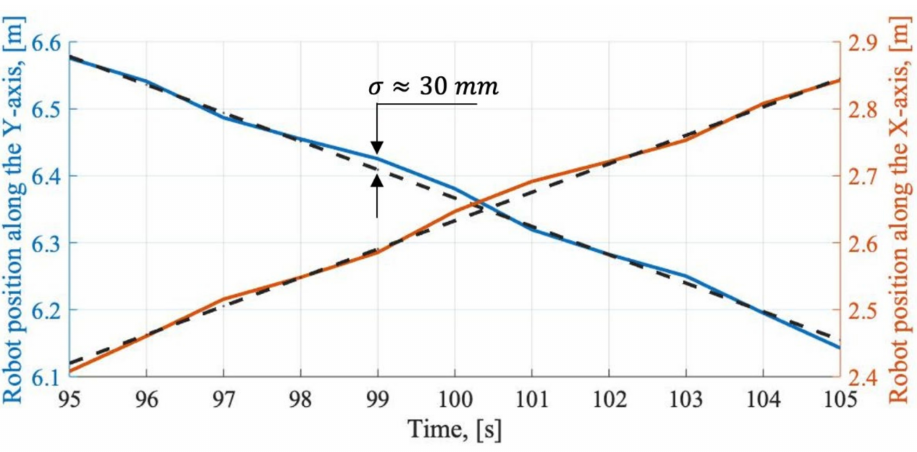
Figure 13. Trajectories of x and y coordinates of the mobile robot’s gravity